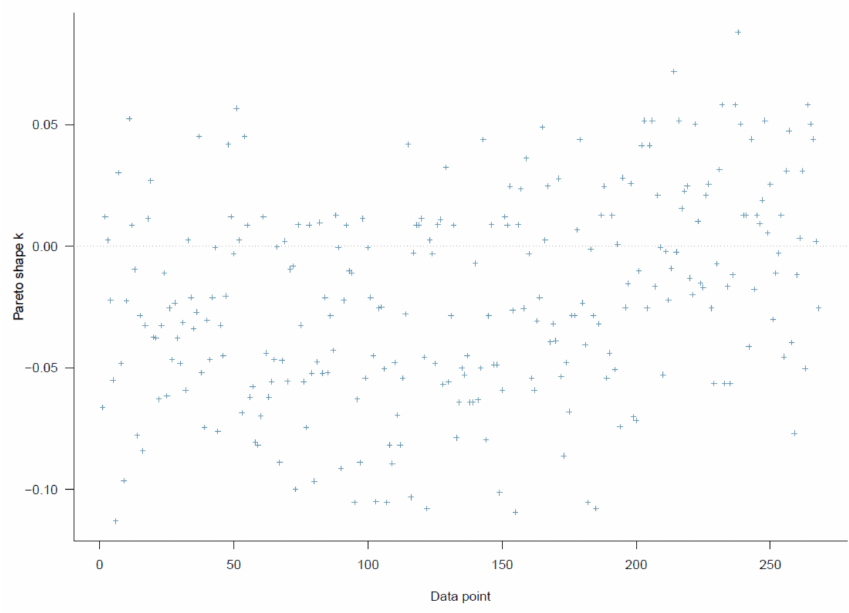
Figure 7. Model 2 (cid:48) s PSIS diagnostic